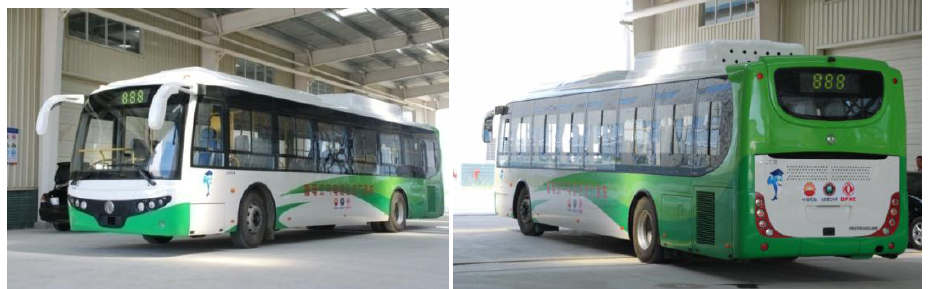
Figure 9. Real vehicle platform. Figure 8. Real vehicle platform. Table 2. Main parameters of hybrid electric vehicles (HEV)’s major components. Table 2. Main parameters of hybrid electric vehicles (HEV)’s major